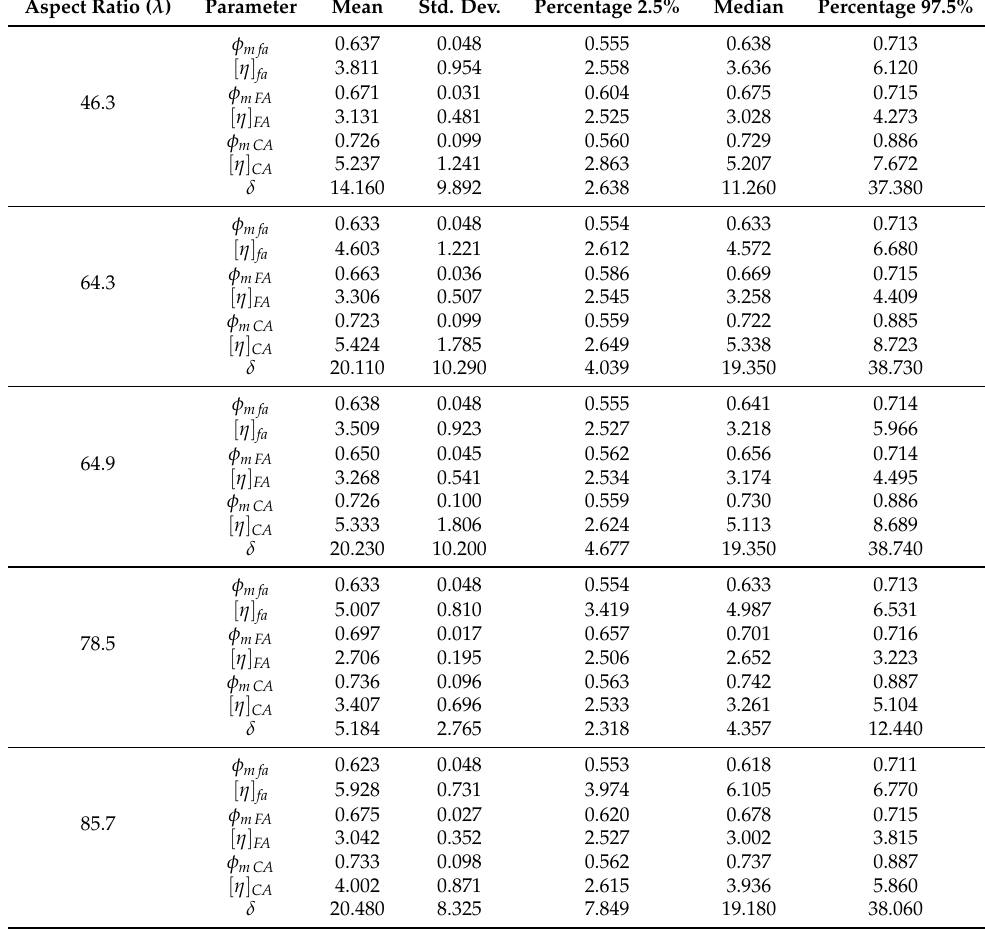
Figure 2. Bayesian network graph of the De La Rosa et al. model [15] for SCSFRC (from the investigation of Grünewald [32]). Table 4. Statistics values of the parameters φ mi , [ η ] i , and δ i for SCSFRC. Aspect Ratio ( λ